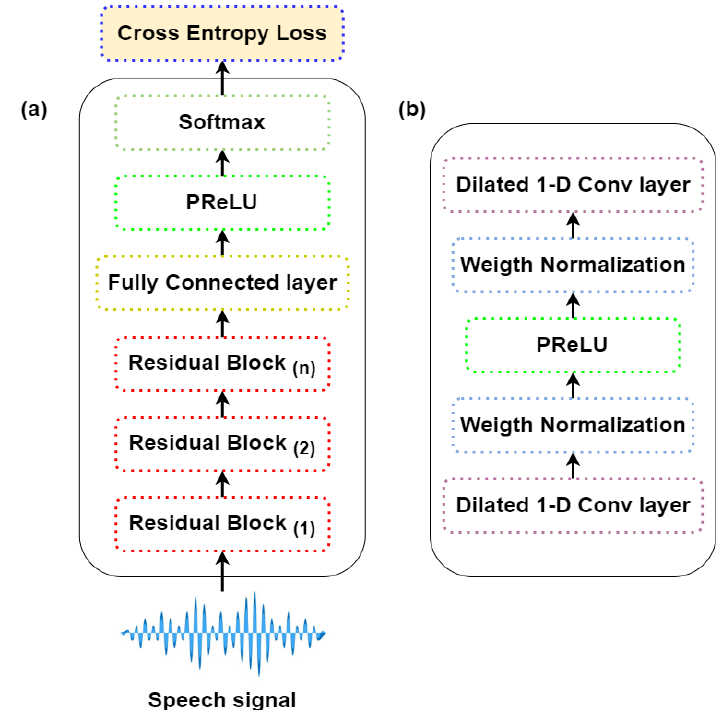
Figure 4. The general architecture of: ( a ) Time Convolutional network for intent classification. ( b ) The architecture of the residual block